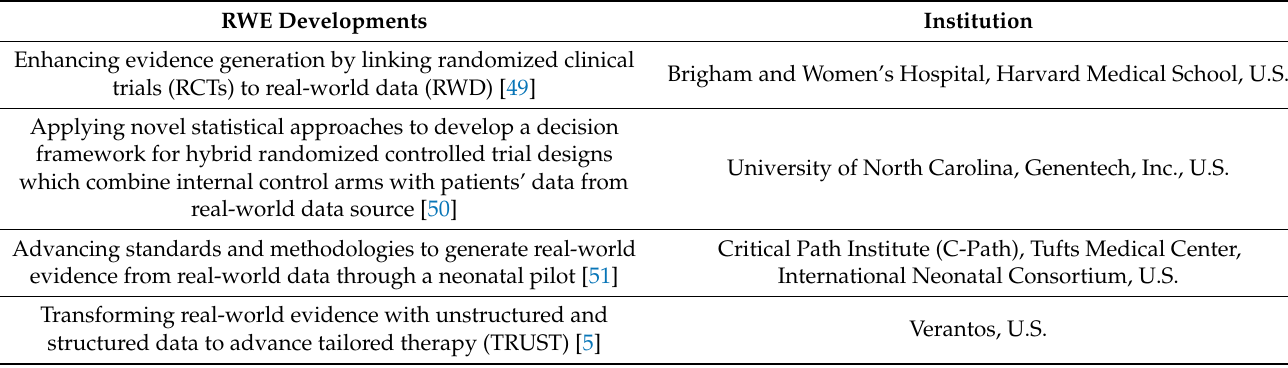
Table 2. FDA-funded RWE research projects for the utility of